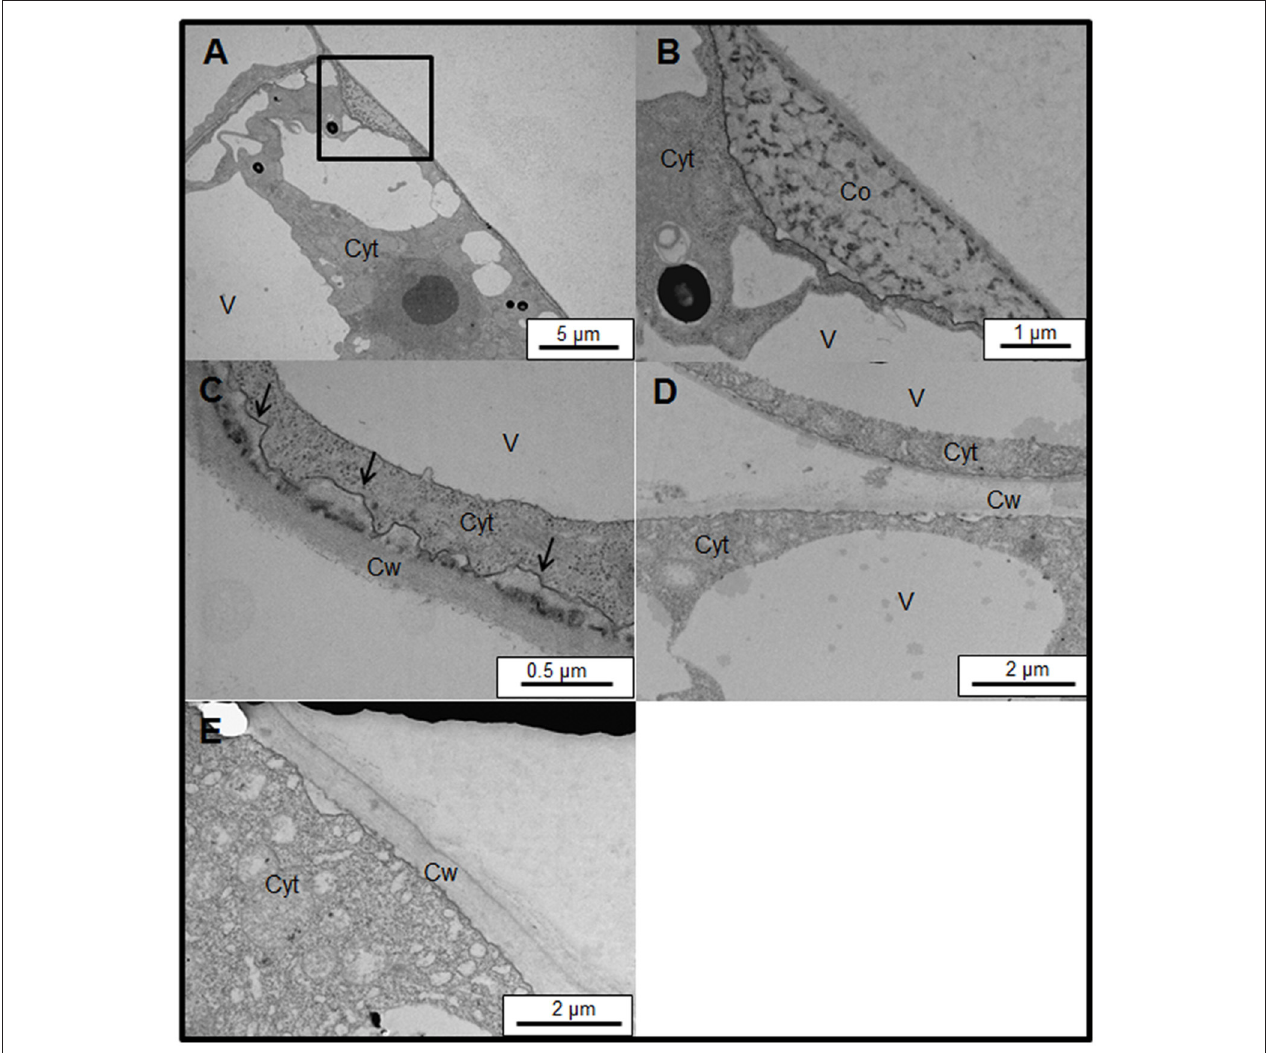
FIGURE 7 | Subcellular location of Yariv reagent precipitation by transmission electron microscopy on samples of control (A–C) and salt-adapted (D,E) tobacco BY-2 cells. (A) Ultrastructure of control tobacco cells treated with 100 µ M Yariv reagent for 24 h. Yariv precipitate is located between the plasma membrane and cell wall (see square). (B) Detail from image (A) showing the coil structure of Yariv precipitate showing a coil structure formed by dense filaments. (C) A high magnification showing the detachment of plasma membrane from the cell walls (arrows) in control tobacco cells treated with 100 µ M Yariv reagent for 24 h. (D,E) Ultrastructure of salt-adapted tobacco cells treated with 100 µ M Yariv reagent for 24 h. Yariv reagent precipitates were not observed at the plasma membrane. Co, Coil structure of Yariv precipitates; Cyt, Cytoplasm; Cw, Cell Wall; V,